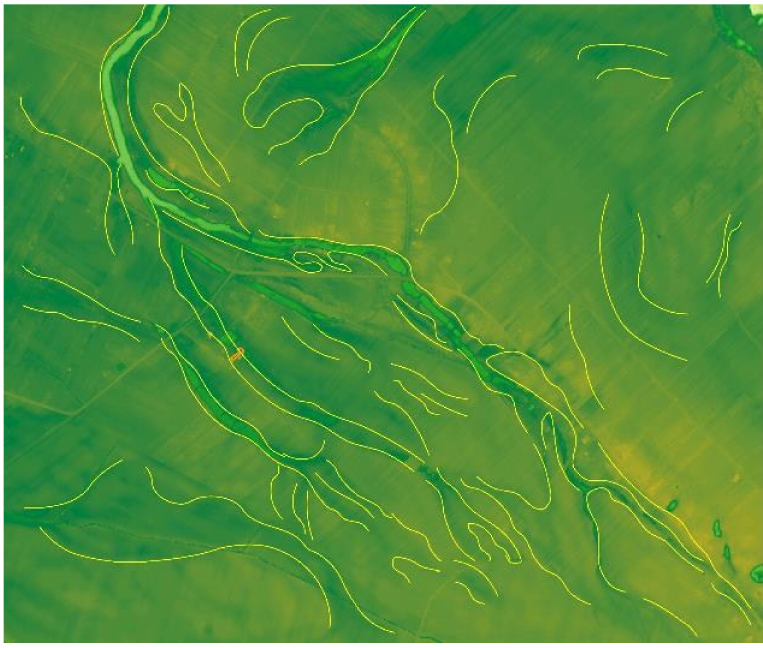
Figure 6. Zoom A: Zone of the transformed floodplain; visible limits of erosional troughs and natural levees that accompany